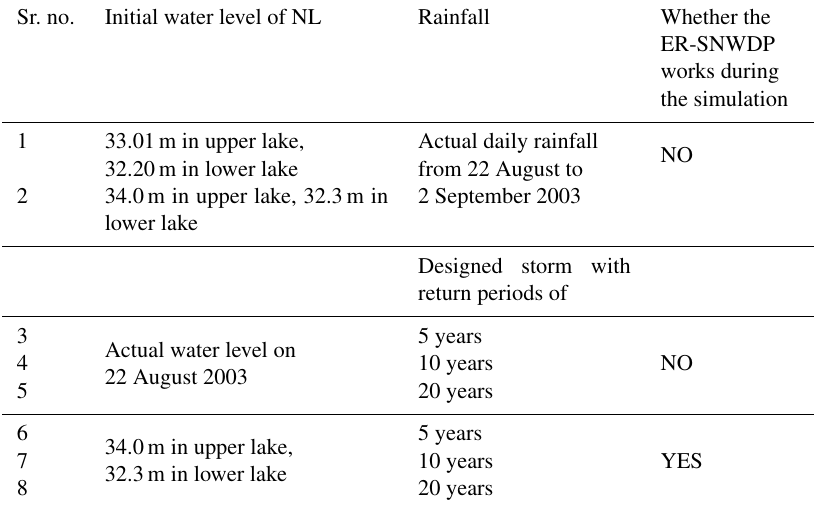
ER-SNWDP works during the simulation